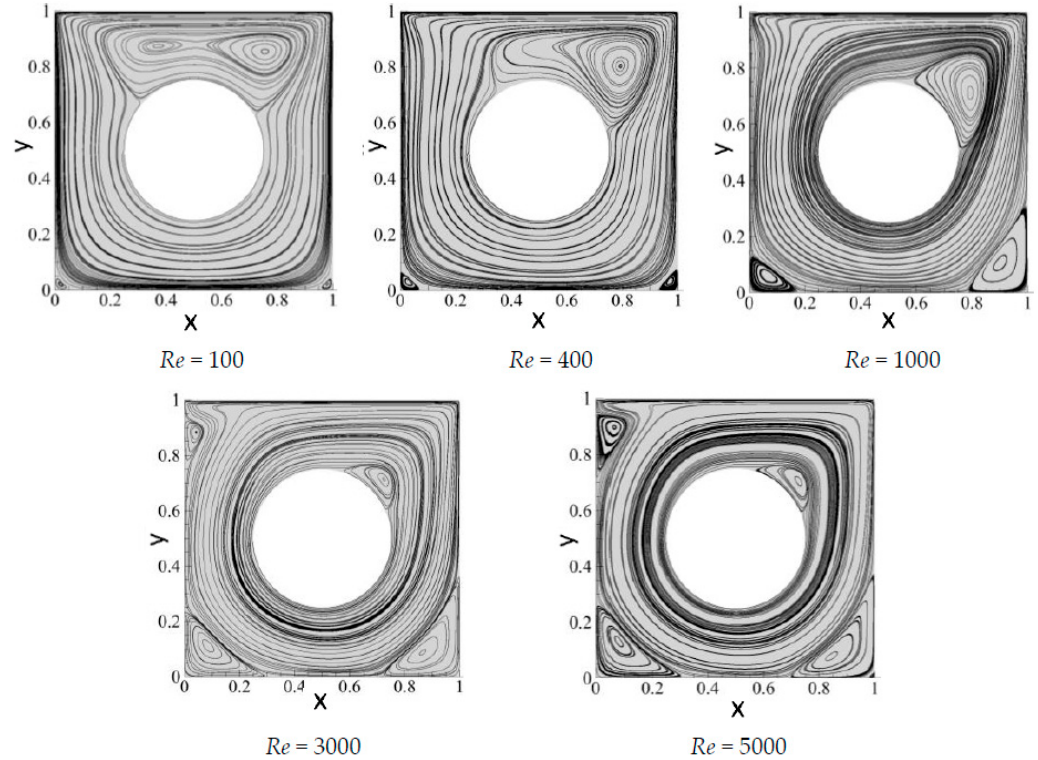
Figure 7. Streamlines of the lid-driven square cavity flow with an embedded circular obstacle at different Reynolds numbers R e at 1/4 r = .